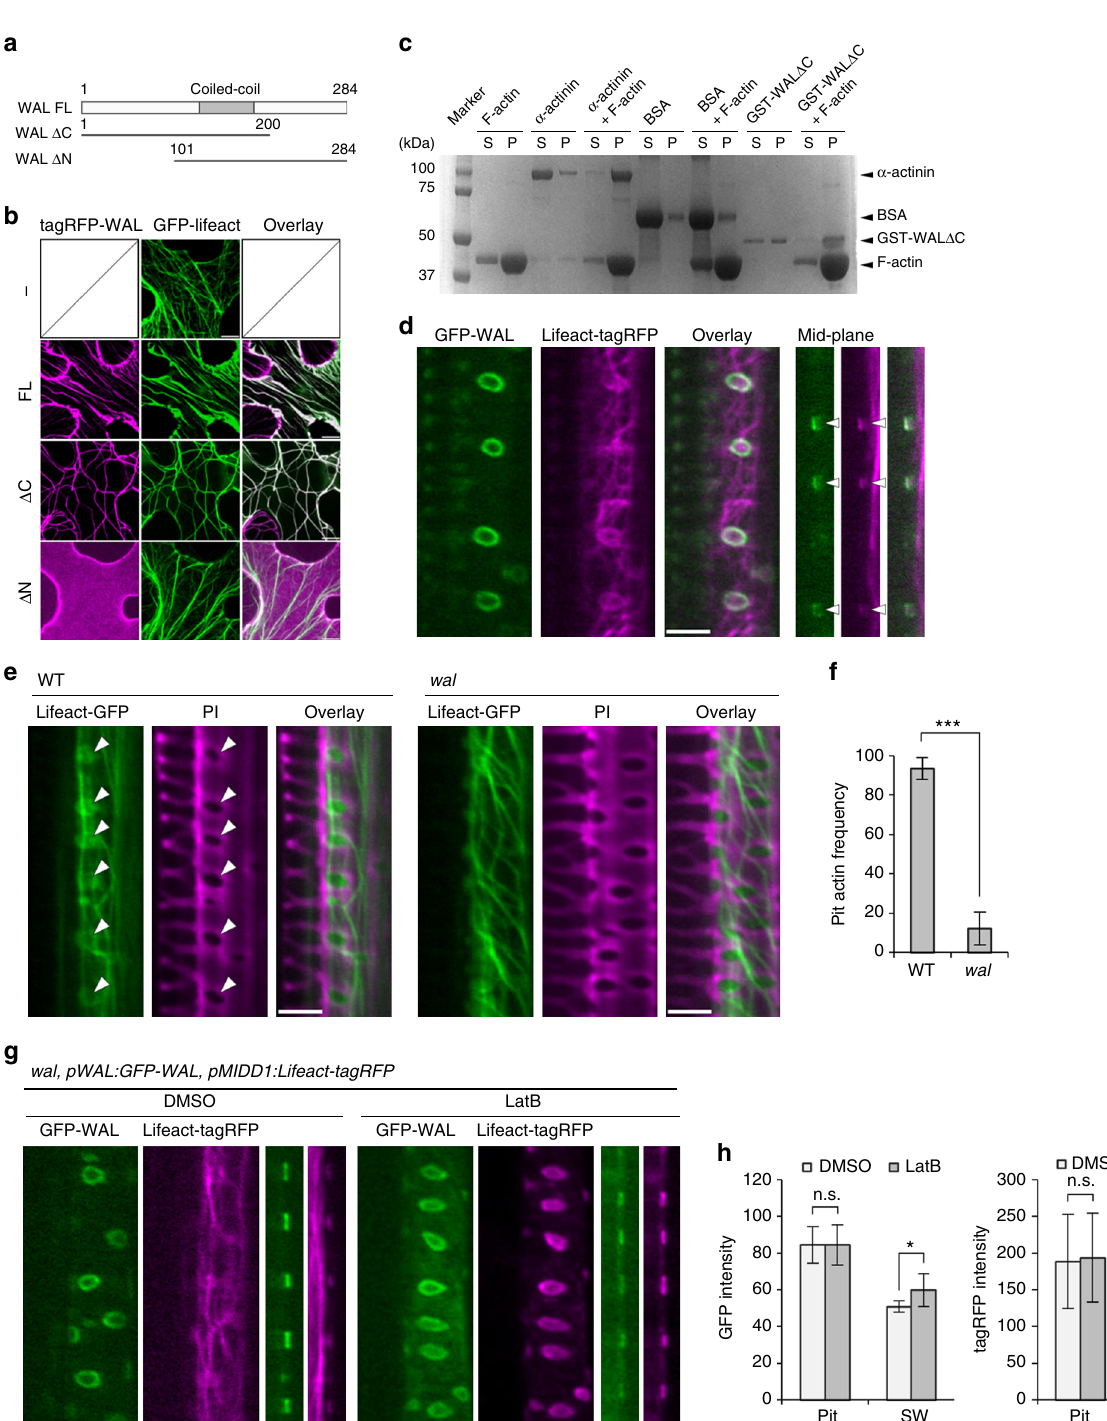
Fig. 2 WAL is required for actin assembly at pits. a Diagram of full-length WAL and truncated WAL fragments. The coiled-coil domain is indicated in gray. Numbers indicate the positions of amino acid residues. b tagRFP-fused full-length (FL) and truncated ( Δ C and Δ N) WAL and actin micro fi laments ( 35S: Lifeact-GFP ) in tobacco leaf epidermal cells. c F-actin co-sedimentation assay. GST-WAL Δ C was detected in the pellet (P) but not in the supernatant (S) after co-sedimentation with F-actin. BSA and α -actinin were used as negative and positive controls, respectively. d GFP-WAL and actin micro fi laments ( pMIDD1:Lifeact-tagRFP ) in metaxylem vessel cells in roots. Cortex (left) and mid-plane (right) from different cells are shown. e Localization of actin micro fi laments ( pMIDD1:Lifeact-GFP ) in metaxylem vessel cells in roots of wild-type and wal plants. Arrowheads indicate actin micro fi laments in secondary cell wall pits. f Frequency of actin micro fi laments in secondary cell wall pits. Values are mean ± s.d. ( n > 200 pits), *** p < 0.001 (Student ’ s t -test). g GFP- WAL and actin micro fi laments (Lifeact-tagRFP) in metaxylem vessel cells in roots treated with (LatB) or without (DMSO) 30 μ M latrunculin B for 6 h. h Intensity of WAL and actin micro fi laments inside (pit) and outside (SW) secondary cell wall pits. Values are mean ± s.d. ( n > 150), n.s., not signi fi cant; * p < 0.05; ** p < 0.01 ( t -test). Bars = 10 µ m ( b ) and 5 µ m ( d , e , and g ). Source data are provided as a Source Data fi